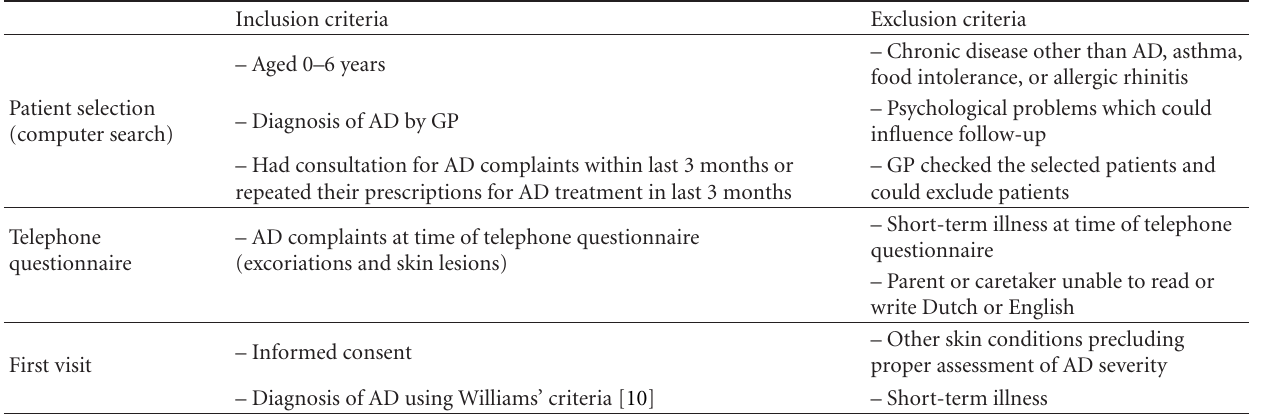
Table 1: Inclusion and exclusion criteria.